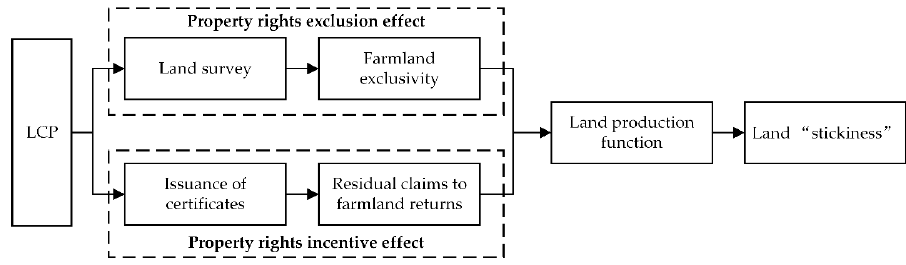
Figure 2. The impact path of the LCP on land